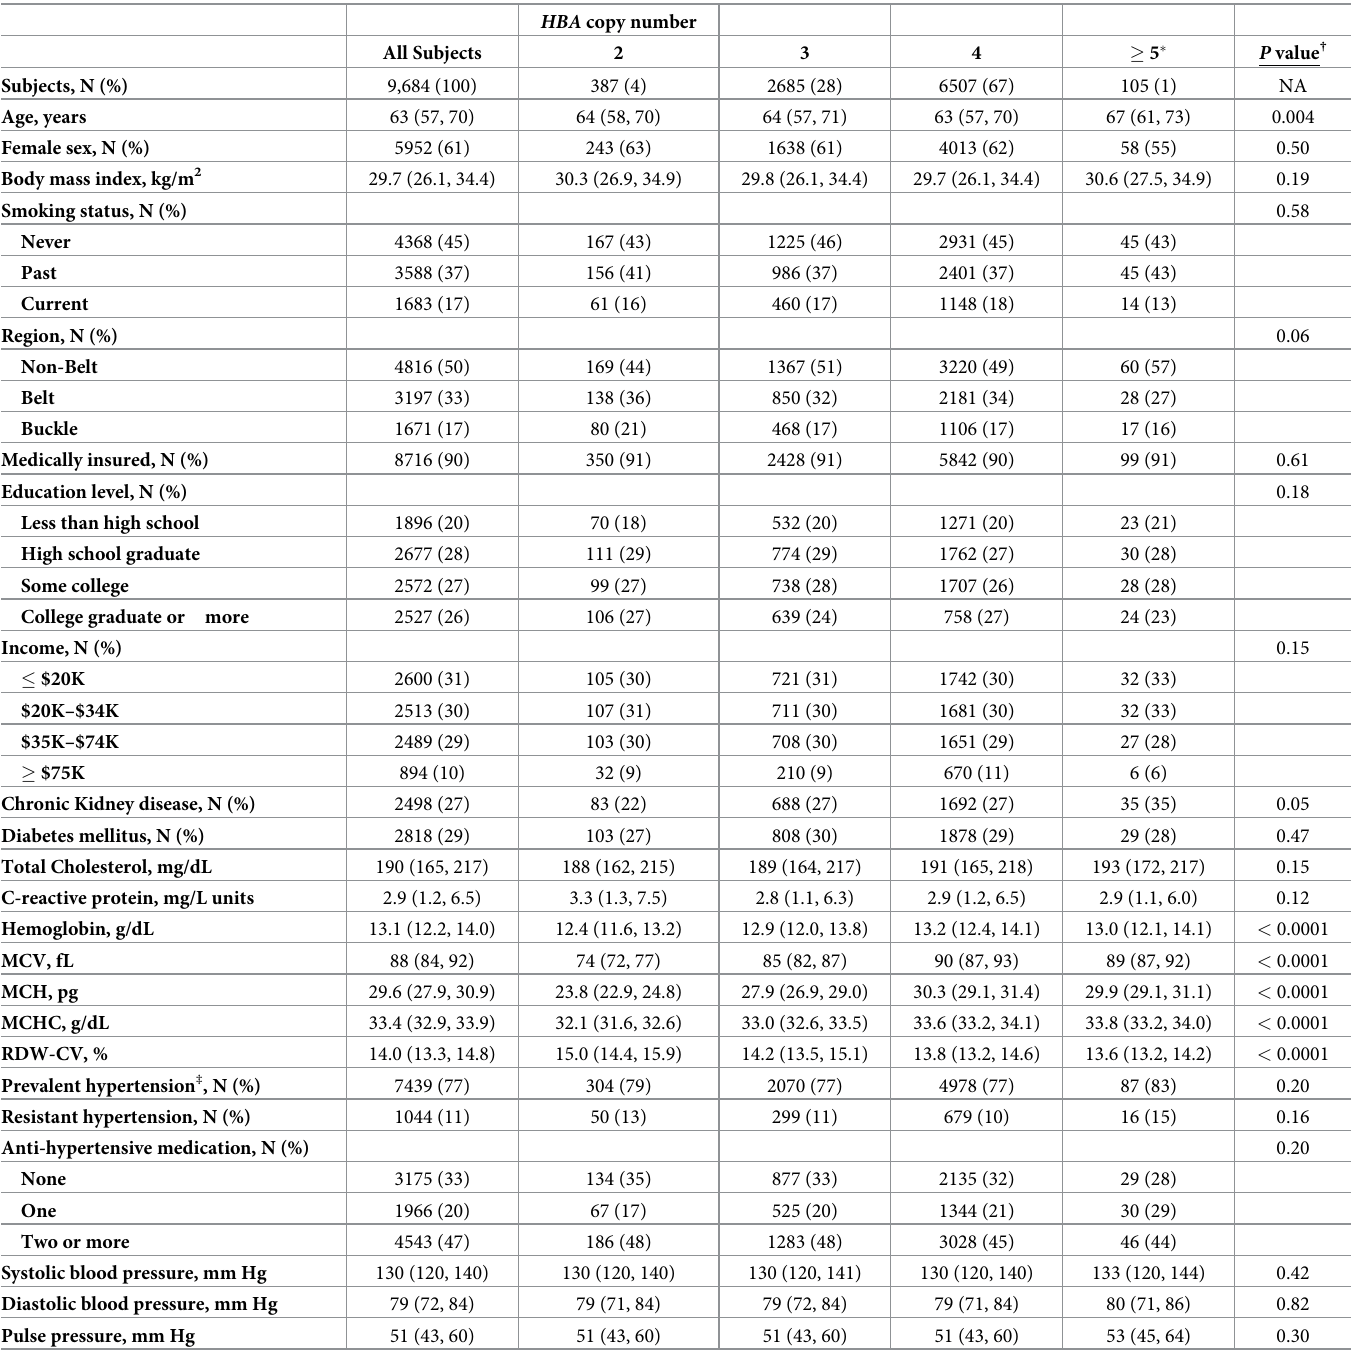
Table 1. Clinical and demographic characteristics according to HBA copy